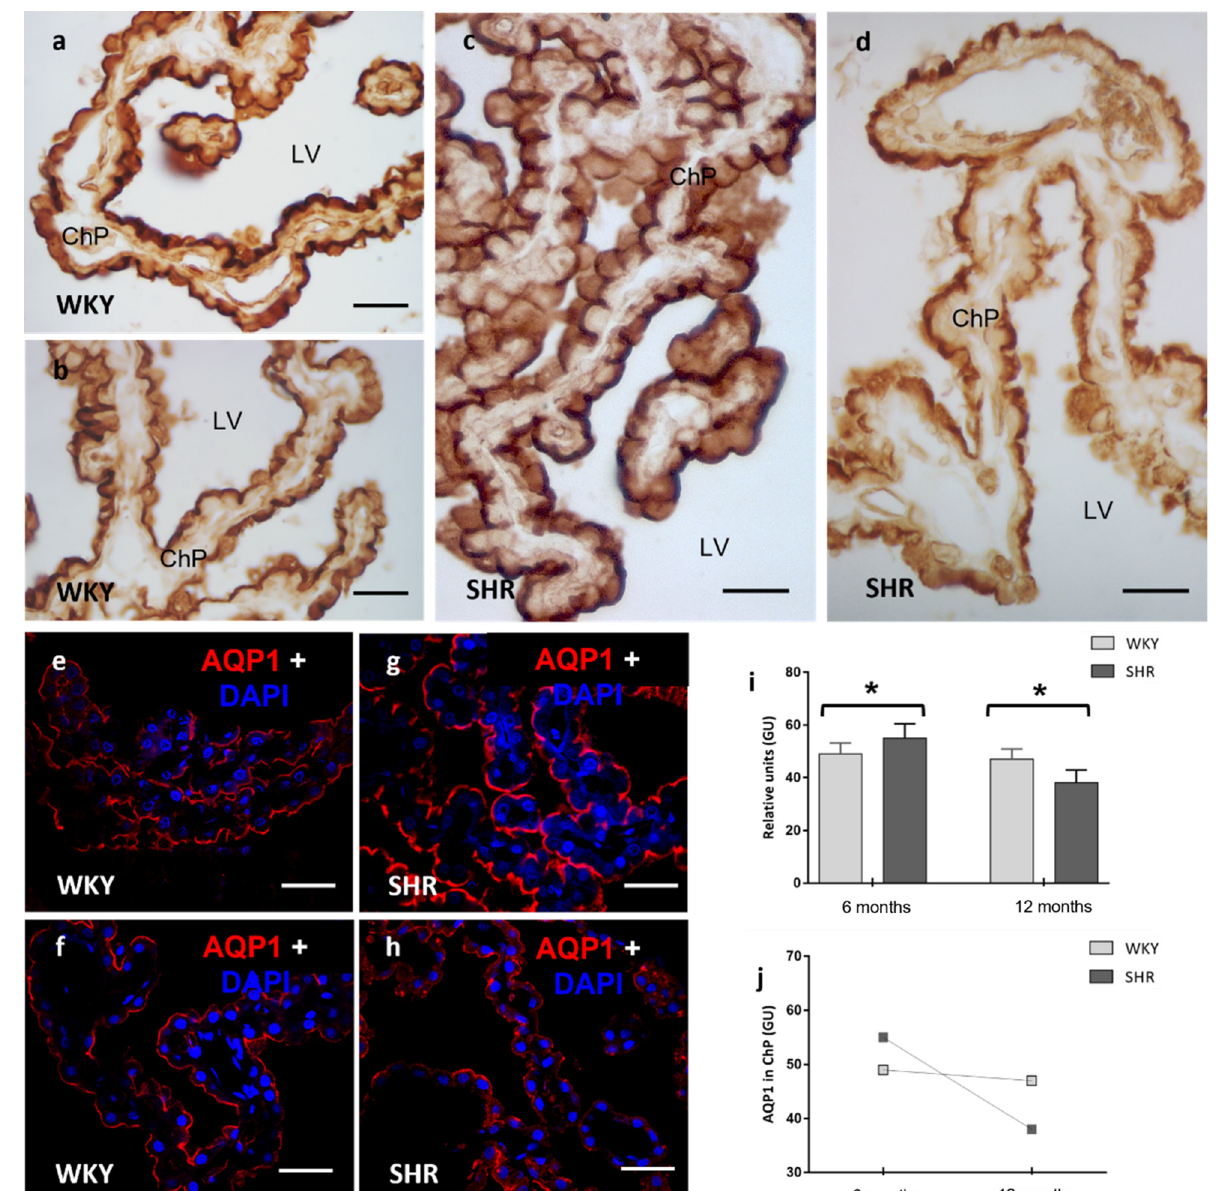
Figure 1. Confocal and optical microscopy images of the immunostaining of AQP1 in the ChP of WKY and SHR rats. An increase of AQP1 was observed in the ChP of SHR in the 6 months group when compared to WKY ( a , c , e , g ), while in the 12 months group, a decrease of AQP1 was observed in the SHR ( b , d , f , h ) rats. At the bottom, stain intensities values in relative units (gray units) for AQP1 ( i , j ) are represented as the means ± SD ( n = five animals per group). The differences between WKY and SHR were significant. One-way ANOVA test with post hoc analysis using the Tukey post hoc test (* p < 0.05) was applied. LV: lateral ventricle; ChP: choroid plexus; GU: grey units. Scale bars 40 μ m.